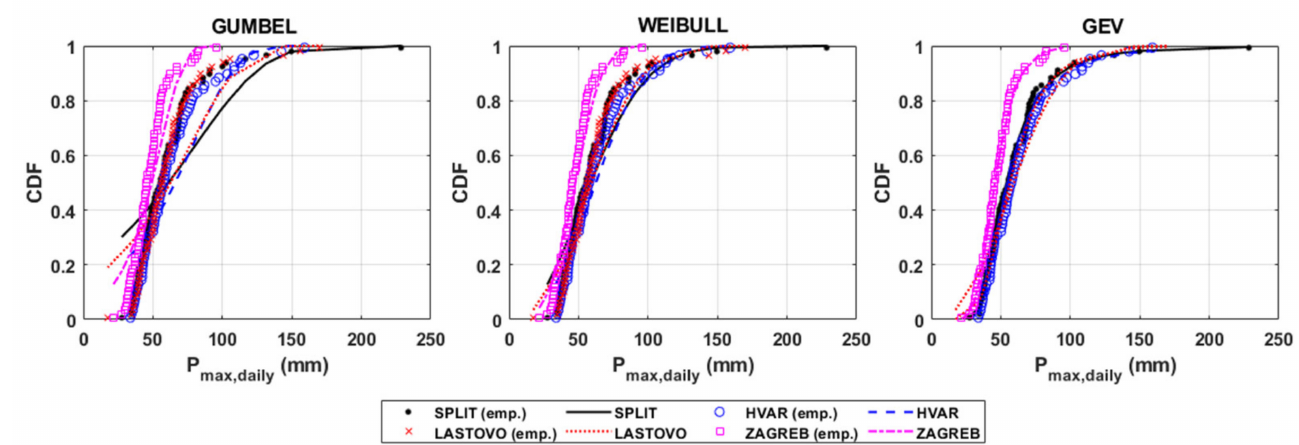
Figure 2. Cumulative distribution functions of the maximum daily precipitation values for the four measuring stations, determined with Gumbel, Weibull and GEV distribution.